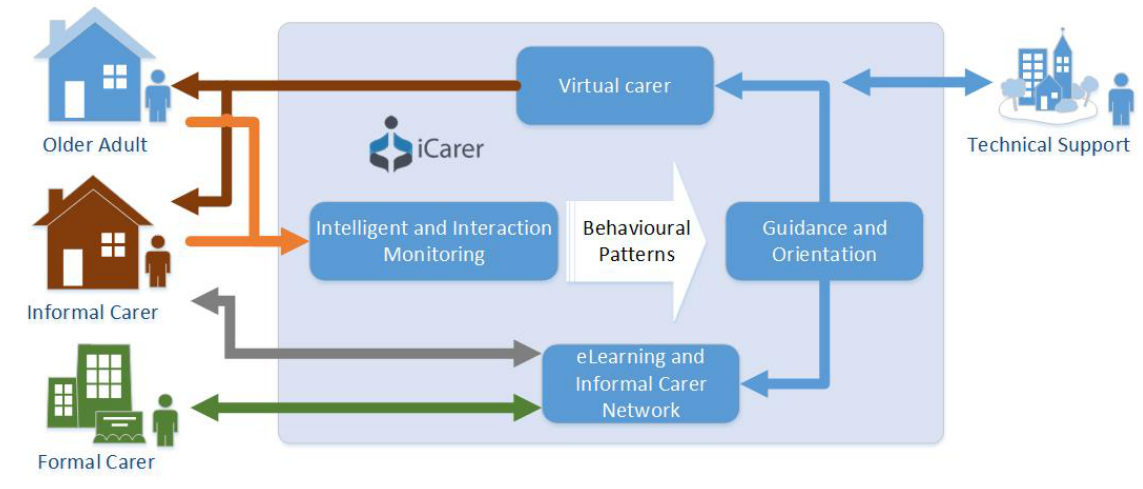
Figure 2. The iCarer platform